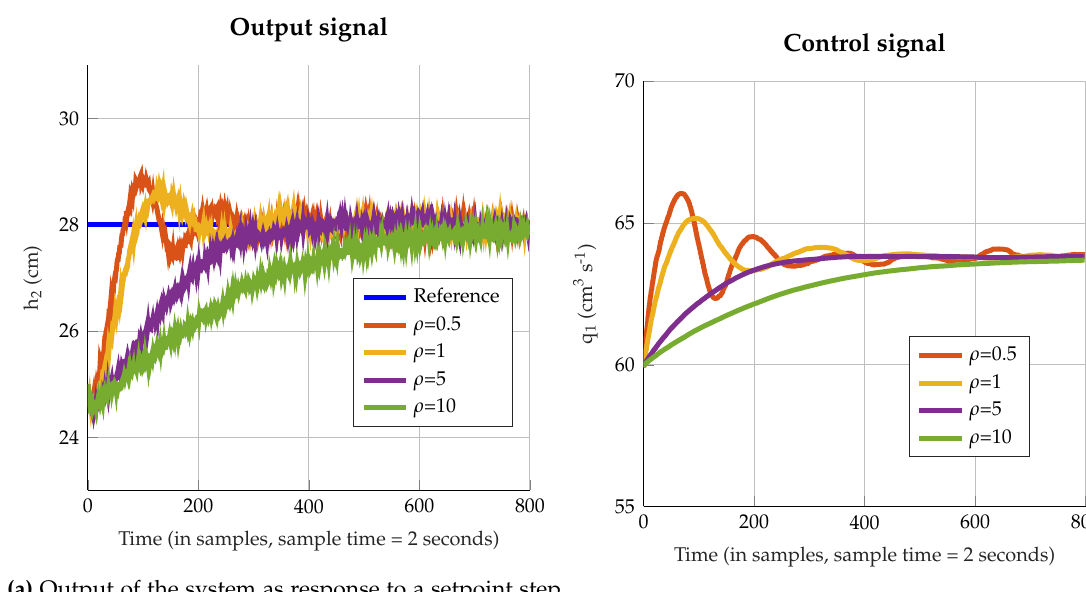
Figure 10. Influence of the parameter ρ (Control action attenuation factor) in the dynamic behavior of the control system.